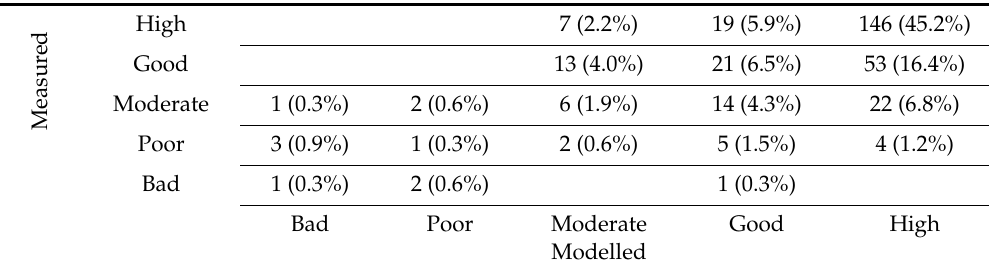
Table 4. Matrix of the number (and percentages) of modelled and measured standing waters within each WFD class.